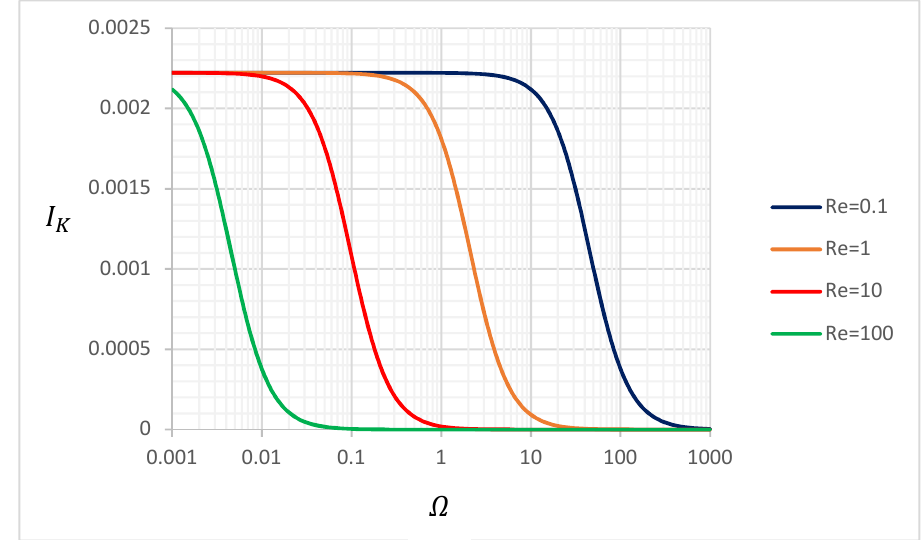
Figure 13. Dependency of the dispersion enhancement coefficient with dimensionless frequency and Reynolds numbers for n = 0.75 and ε = 0.1.